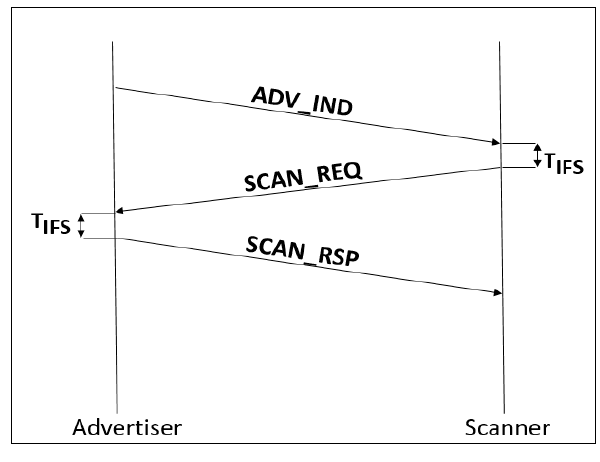
Figure 3. Advertiser discovery by the scanner.